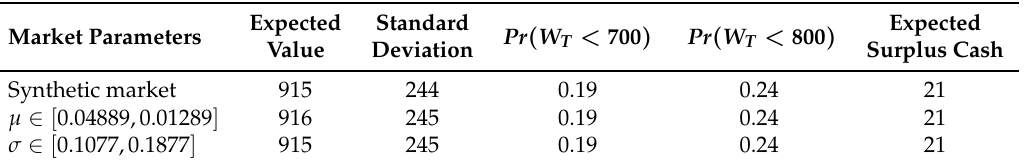
Table 4. Base case scenario results for the QS optimal strategy with random variation of market parameters µ and σ , Wealth units: thousands of dollars. Input data provided in Tables 1 and 2, except as noted. Monte Carlo simulations with ( µ , σ ) drawn from a uniform distribution with the indicated limits along each of 160,000 paths. Expected Market Parameters